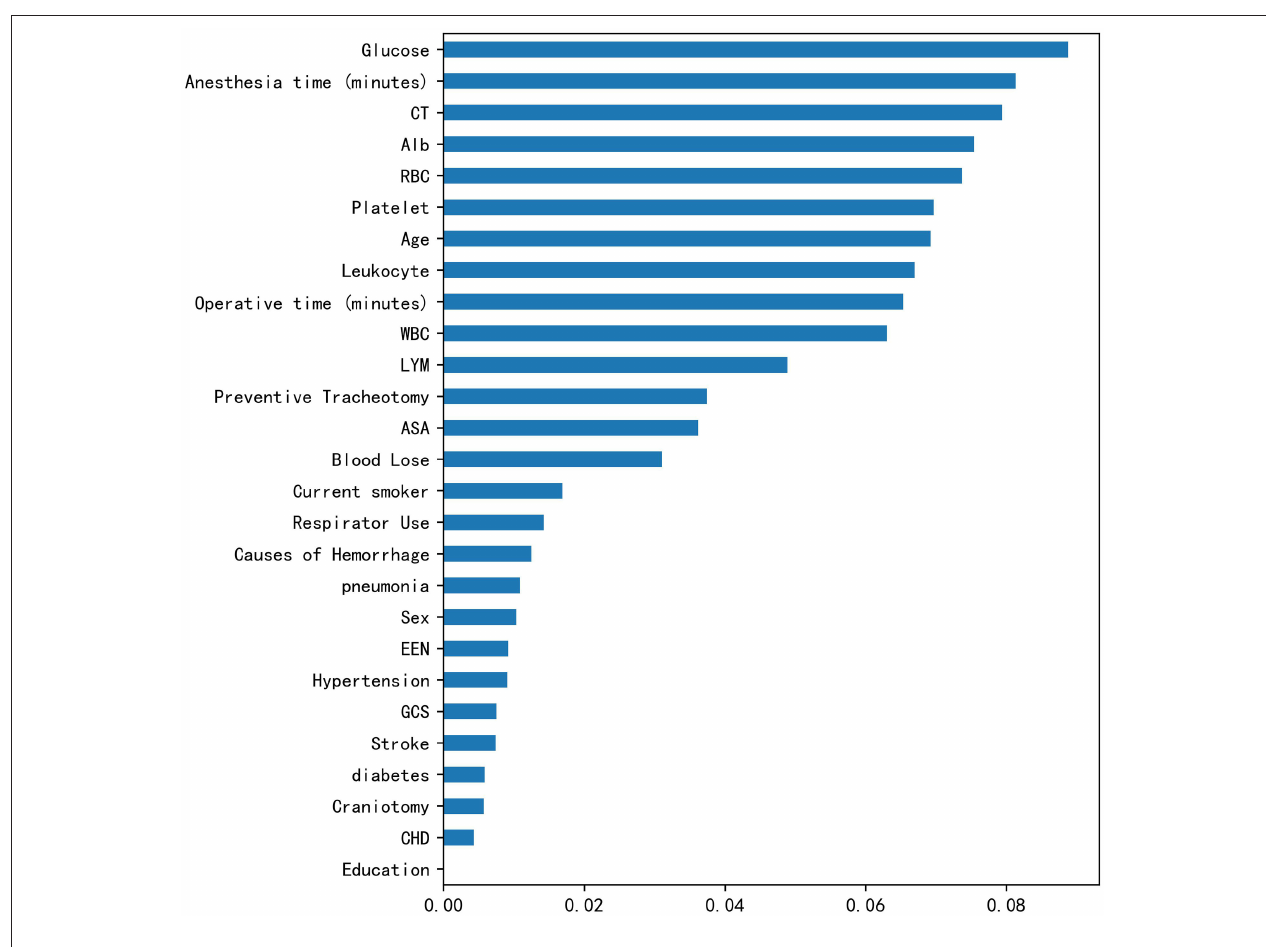
FIGURE 4 | Rank of feature importance of PPC in RF